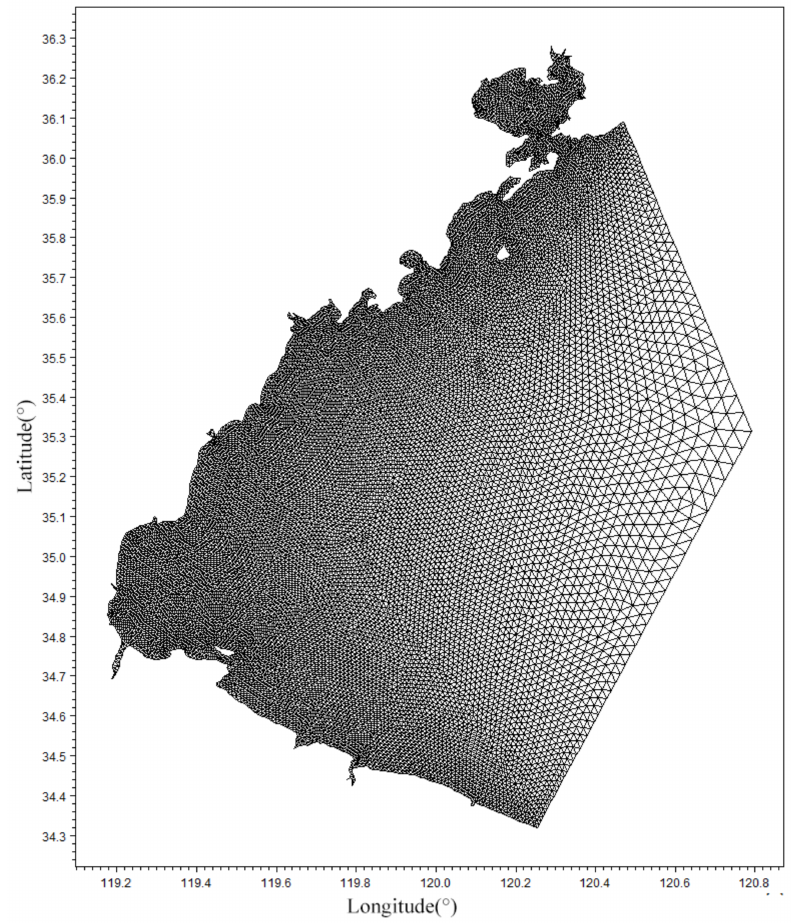
Figure 3. Grid distribution of study